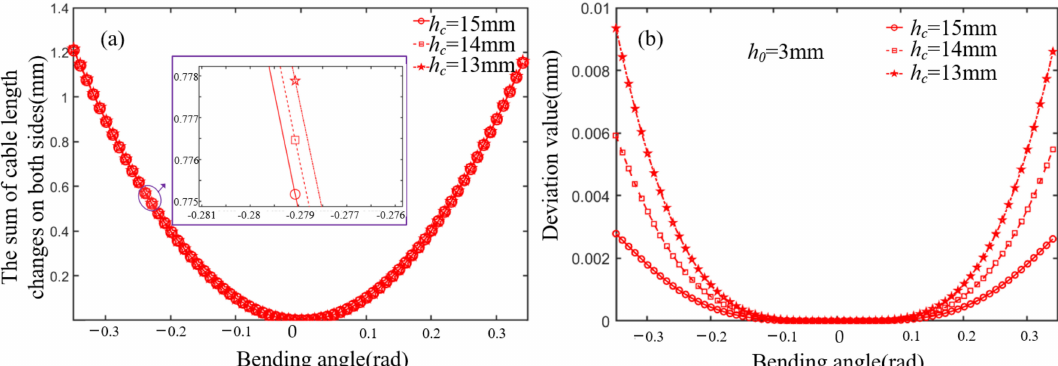
Figure 6. The sum of cable length change on both sides and difference analysis. ( a ) The relationship between the h c and the sum of cable length changes on both sides. ( b ) The deviation value analysis between the h c and the sum of cable length changes in different h c